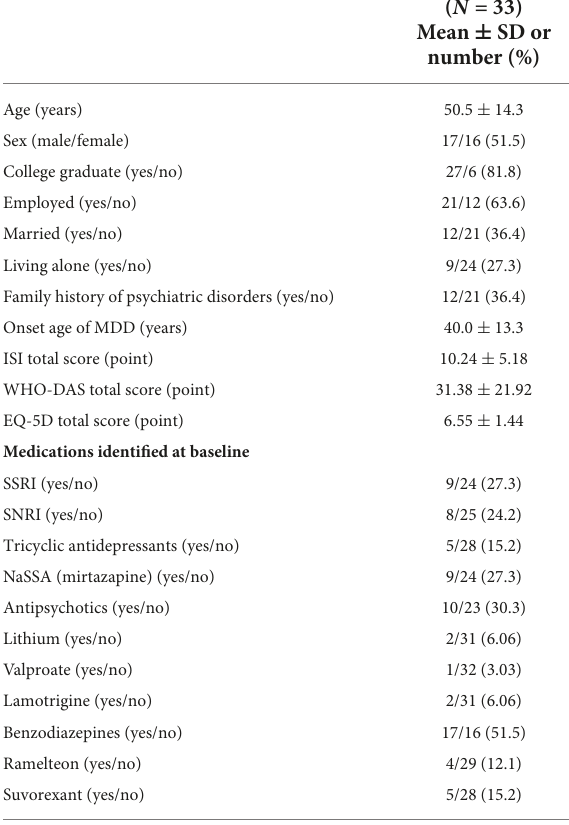
TABLE 1 Participant